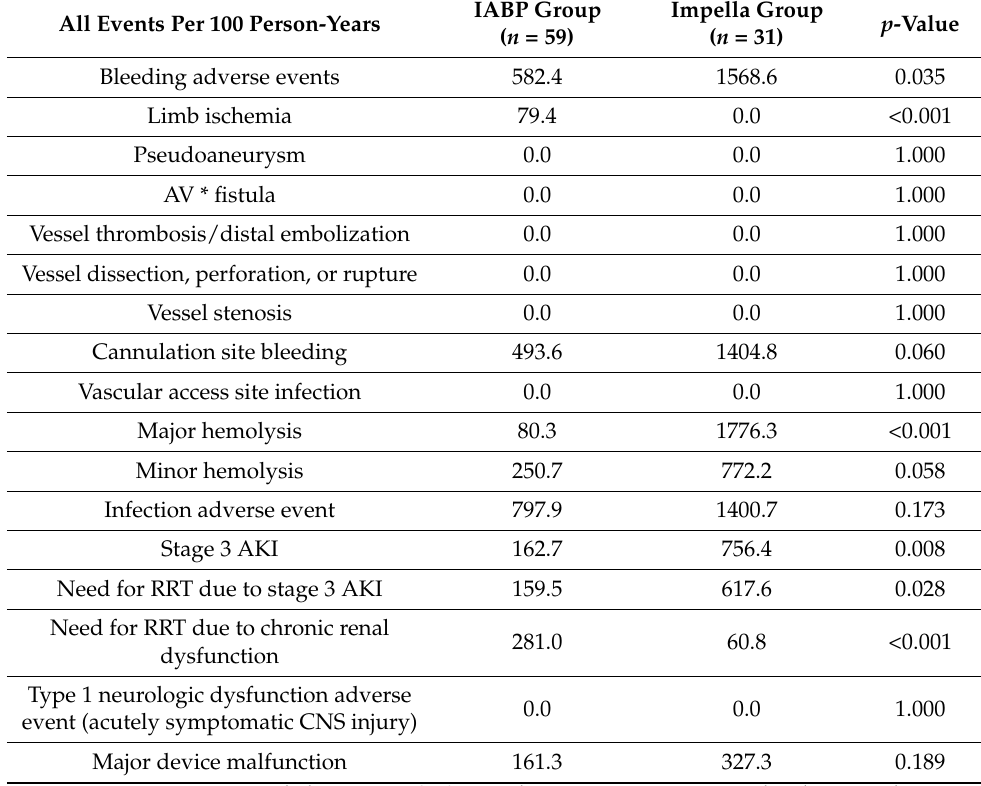
Table 2. Temporary MCS